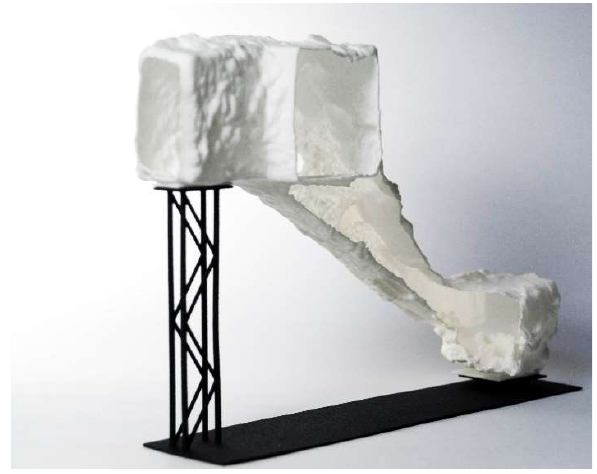
Figure 17. Last corridor of Ipi’s tomb. 3D